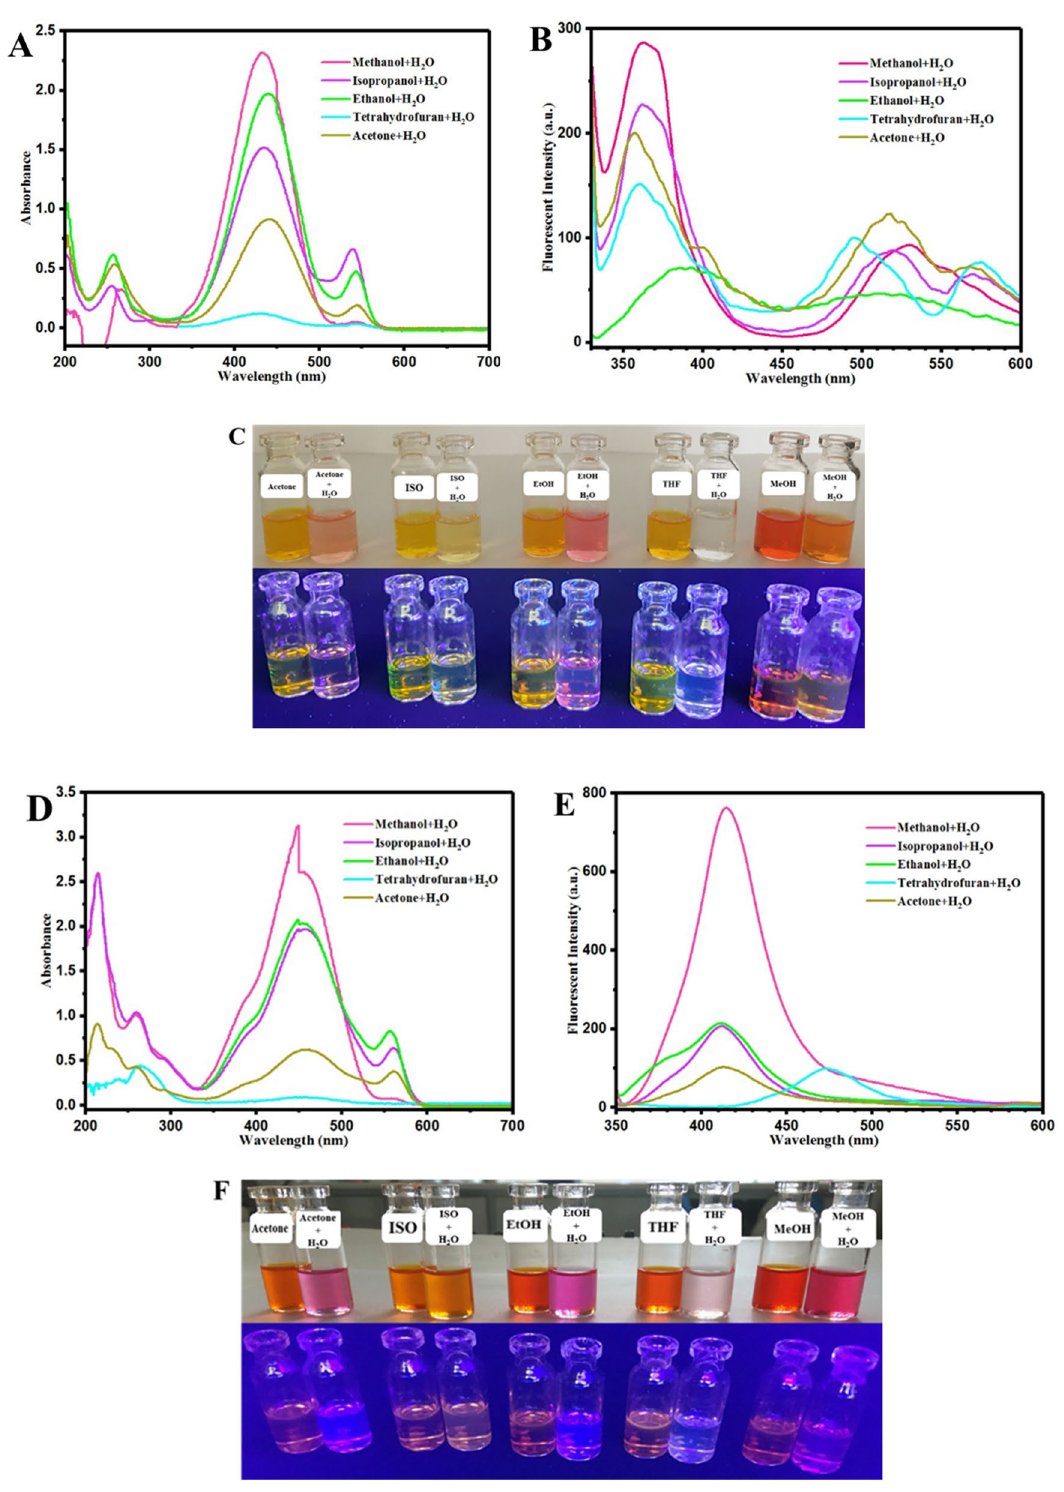
Figure 6. Hydrochromism plots in UV–Vis and fluorescence spectroscopies for ( A ) and ( B ) OX 1 -OH and ( D ) and ( E ) OX 2 -OH solutions and also photographs of hydrochromism phenomenon for ( C ) OX 1 -OH and ( F ) OX 2 -OH solutions before and after addition of water under visible light and UV irradiation (360